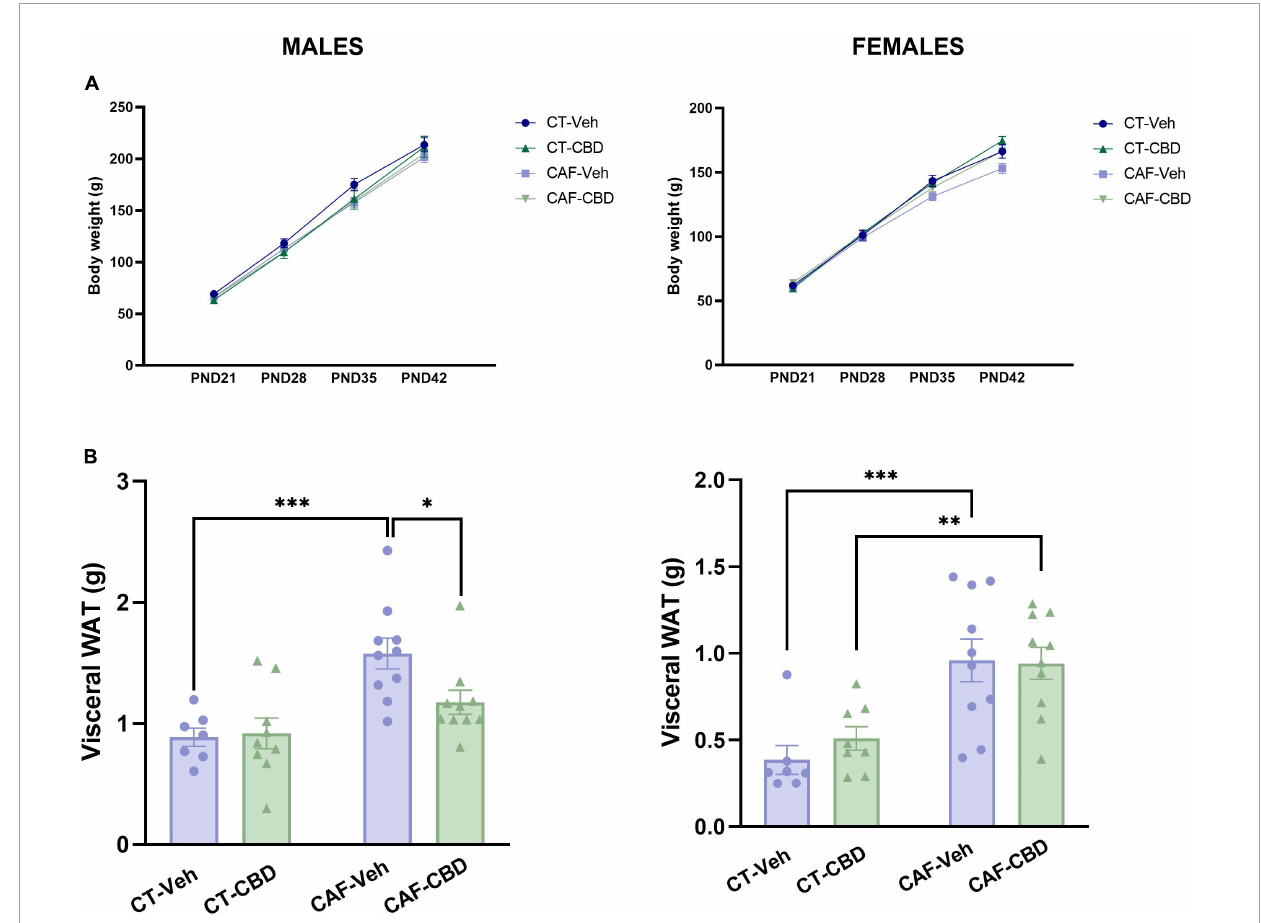
FIGURE3 Offspring’s body weight and visceral white adipose tissue (WAT). Neither male nor female offspring showed influences of maternal diet or cannabidiol (CBD) treatment in weight at weaning (PND21) and the following 3 weeks of treatment (A) . Maternal diet increased visceral fat deposit in both male and female cafeteria diet (CAF)-Veh offspring with CBD effect only in males (B) . Data are presented as mean ± SEM. n = 8–10/group. ∗ p < 0.05 ∗∗ p < 0.01 ∗∗∗ p <